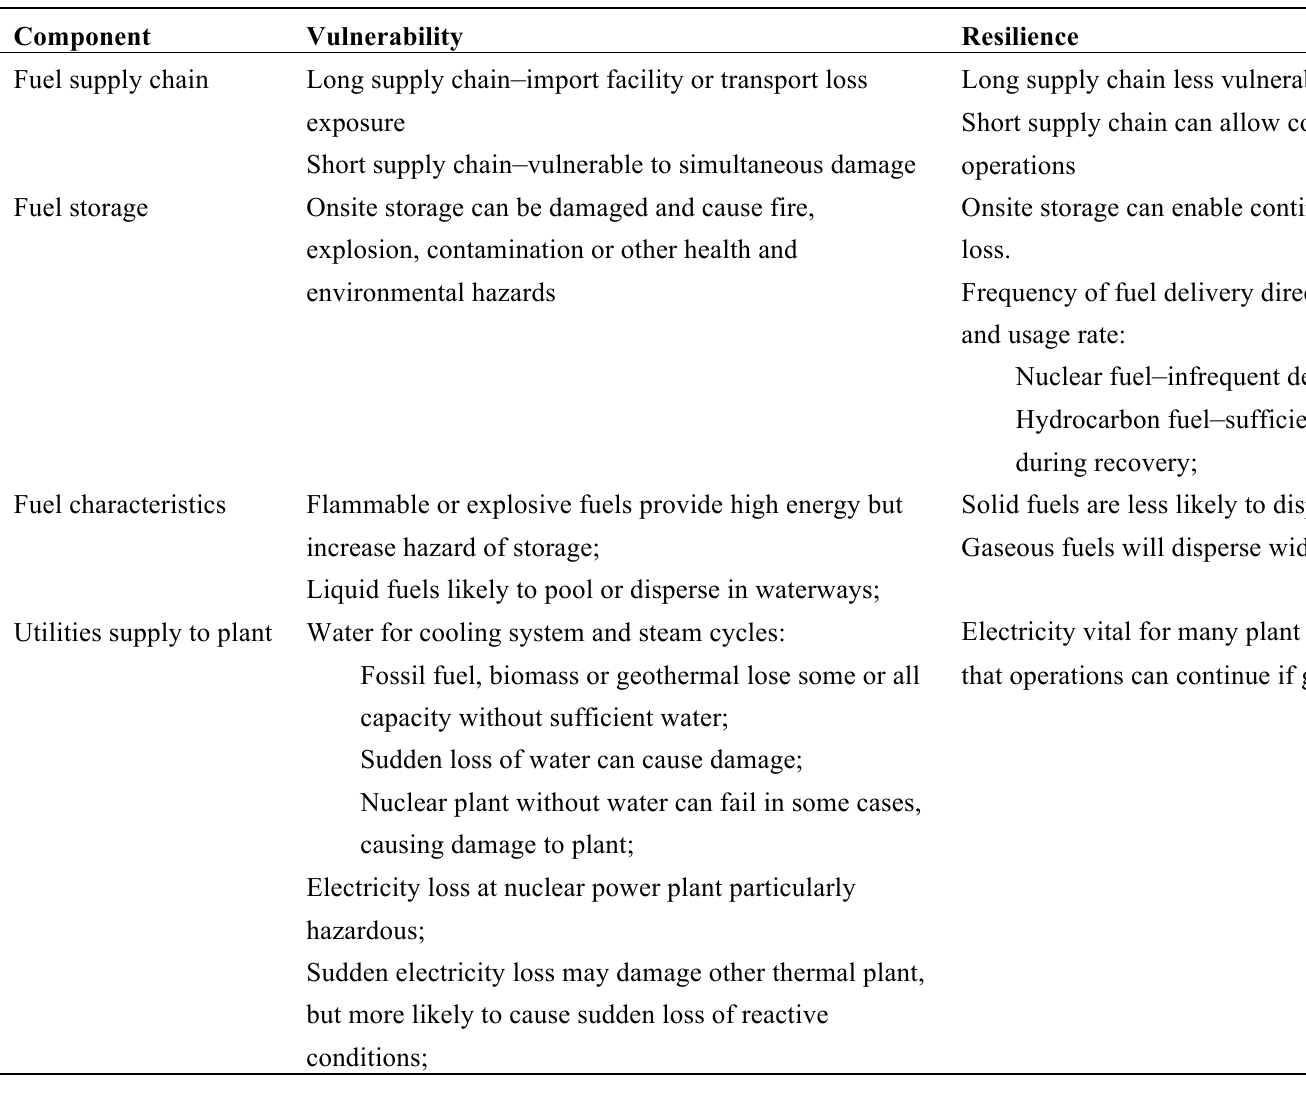
Table 4. System components vulnerability and